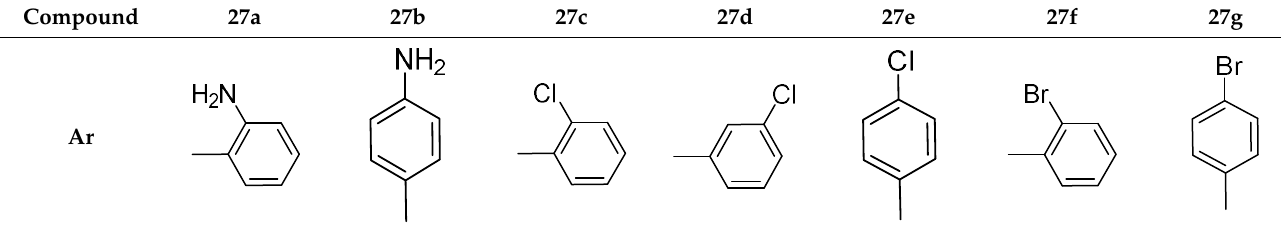
Table 2. List of substituted phenols in 27(a-g).